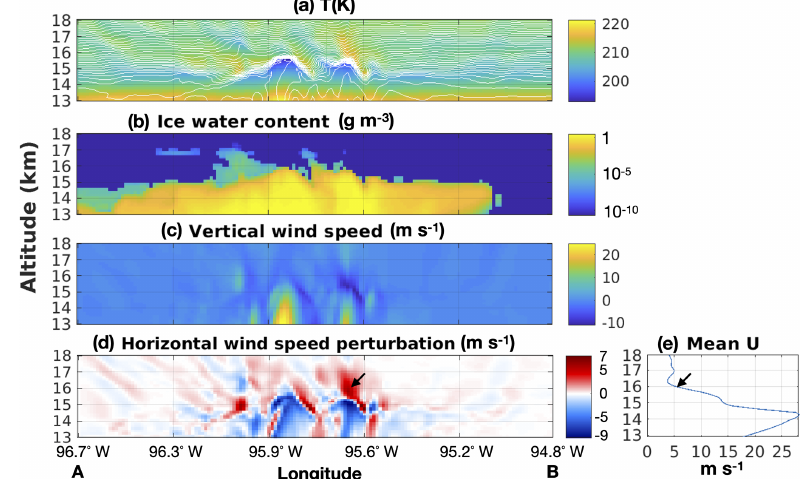
Figure 5. Cross section as shown in Fig. 4 but for 19:42UTC, 25 August 2013: (a) temperature (colour) and potential temperature (thin white lines); (b) ice water content, in logarithmic scale; (c) vertical wind speed, in ms − 1 ; (d) horizontal wind speed perturbation based on Eq. (2), in ms − 1 ; and (e) the mean horizontal west wind